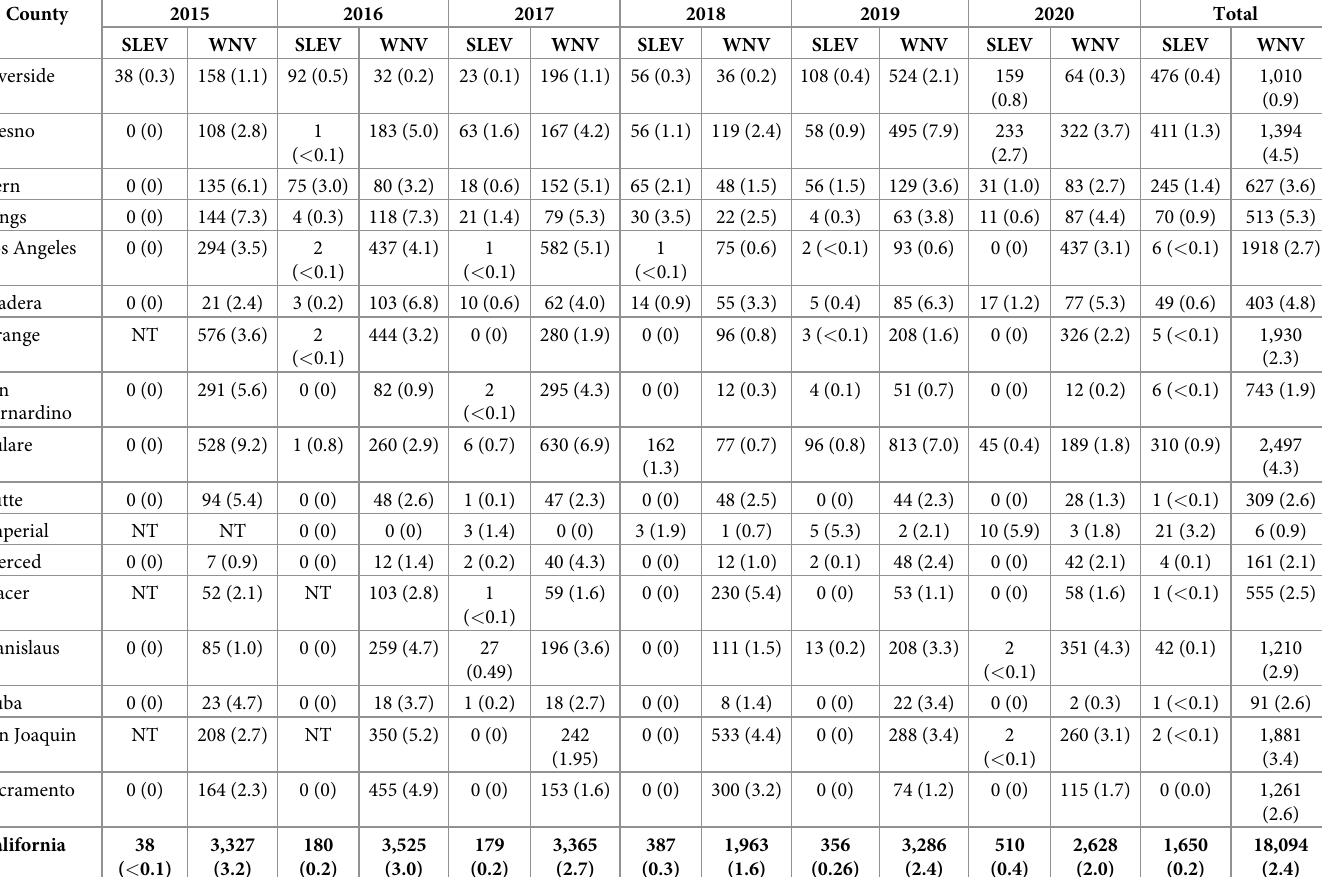
Table 1. Mosquito pool detections of St. Louis encephalitis virus (SLEV) and West Nile virus (WNV) in California counties where SLEV was detected, 2015–2020. Number of positive Culex spp . pools (Mosquito Infection Rate per 1,000